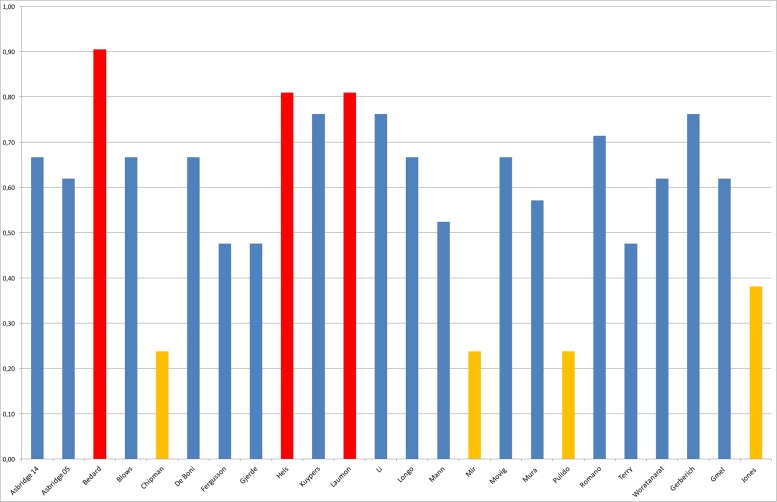
Quality assessment.